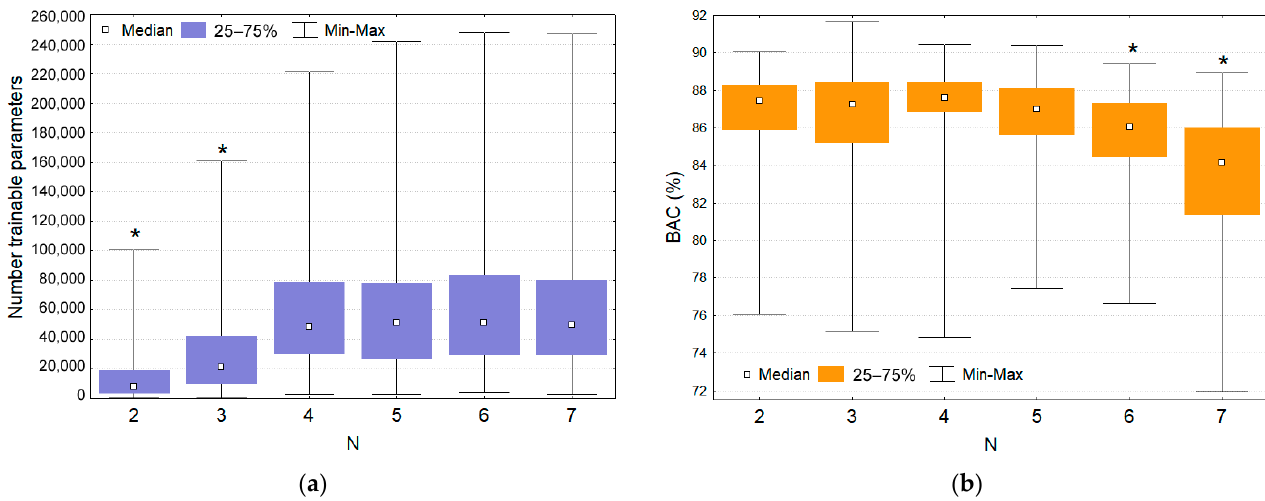
Figure 5. Categorical analysis of random search models: ( a ) Number of trainable parameters; ( b ) Validation BAC perfor- mance, according to the number of convolutional blocks N = {2, 3, 4, 5, 6, 7}. The statistically different distributions are highlighted at p < 0.05 (*).